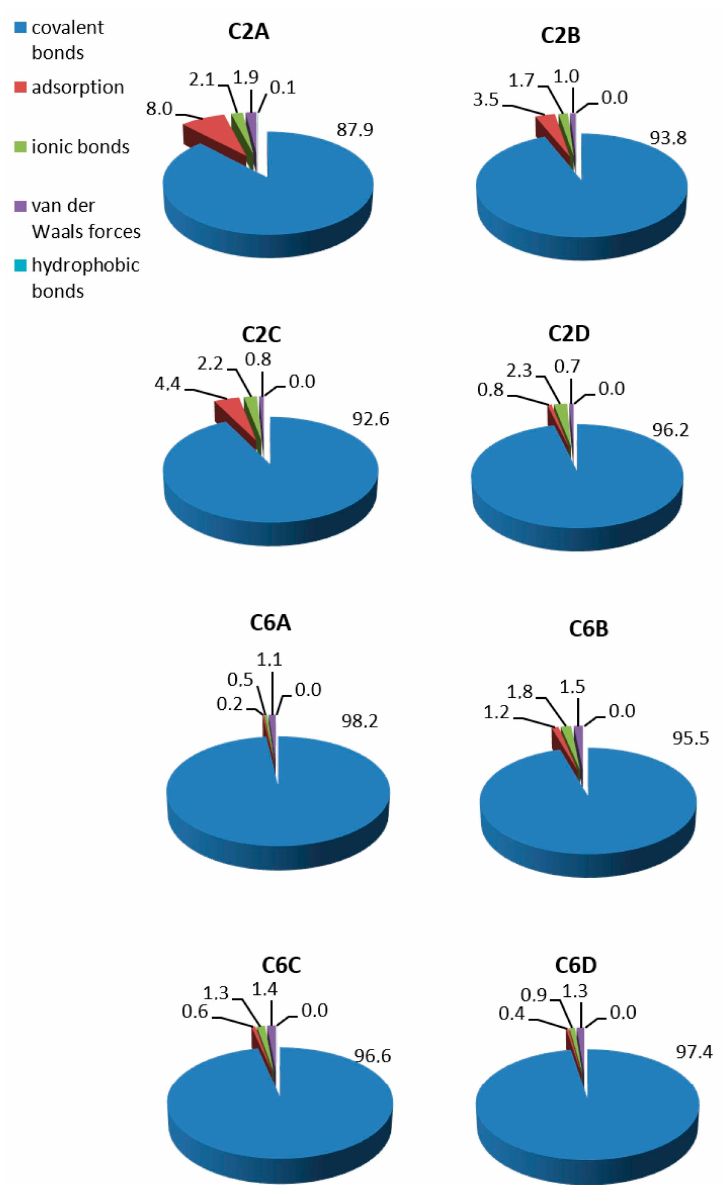
Figure 3. Percentage of bonds formed during immobilisation of LAC on porous carriers with C 2 and C 6 spacer arms.